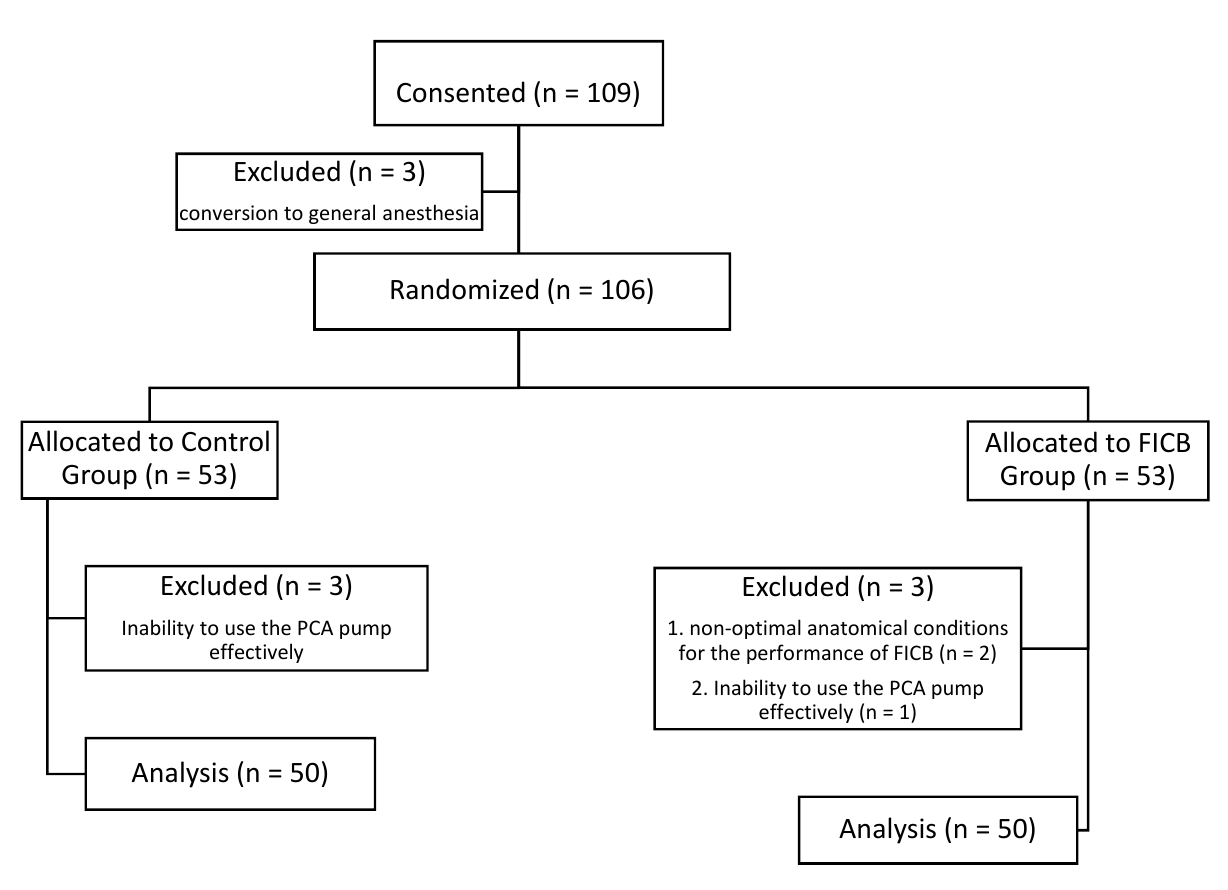
Figure 1. Participant flow diagram.